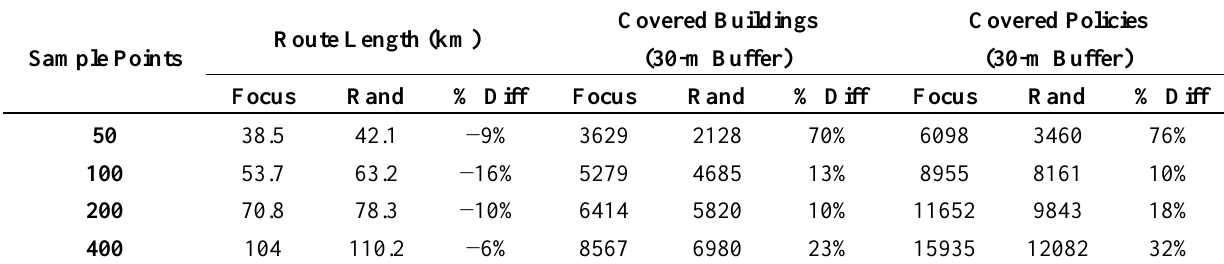
Table 7. Comparison between routing based on random sampling and routing based on focused